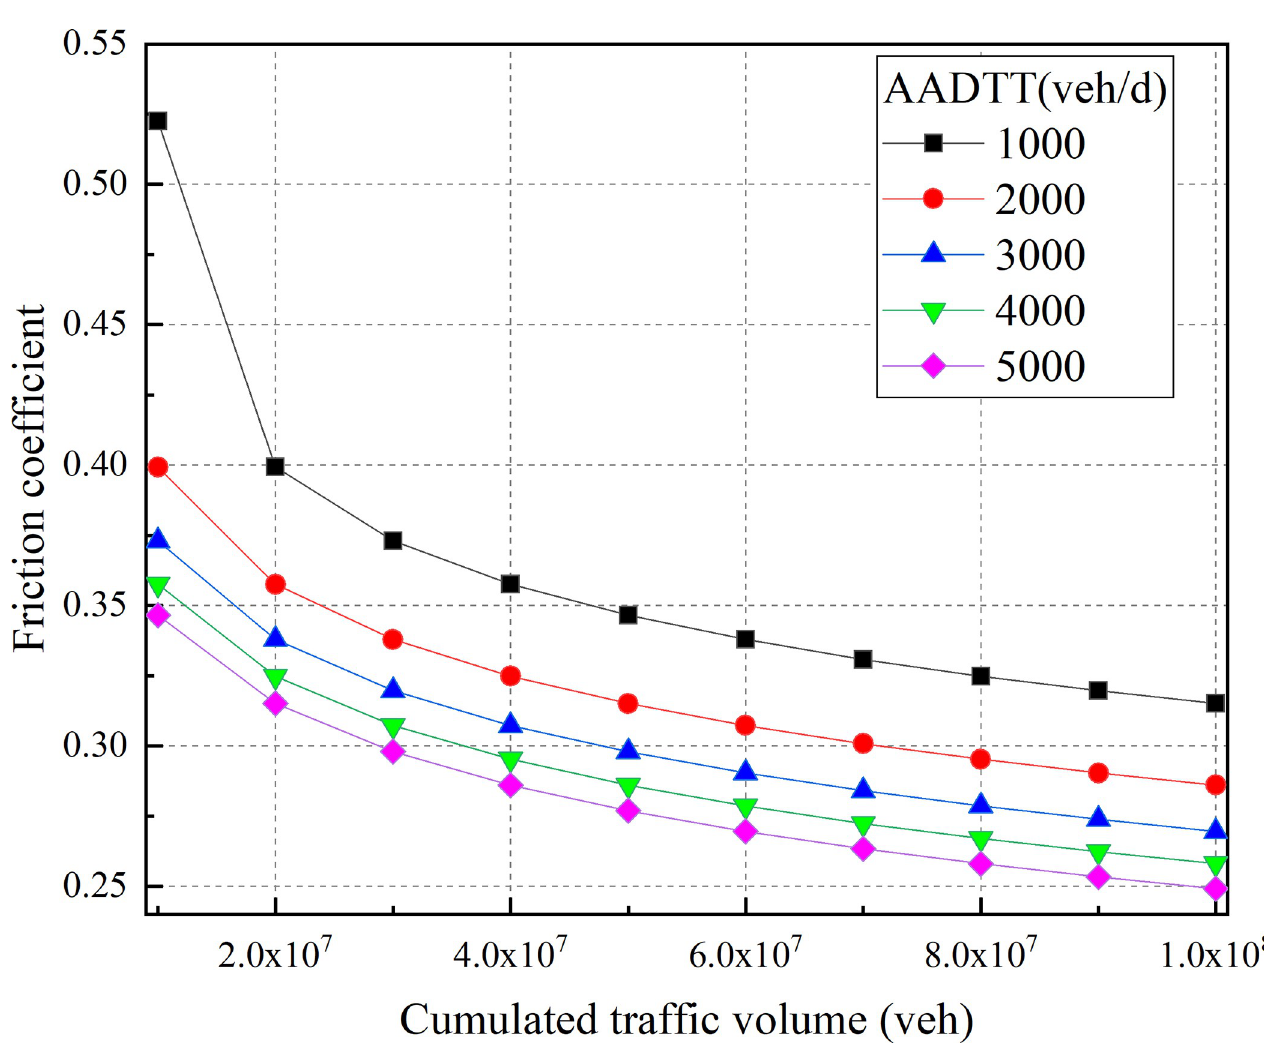
Fig 6. Influence of AADTT on friction